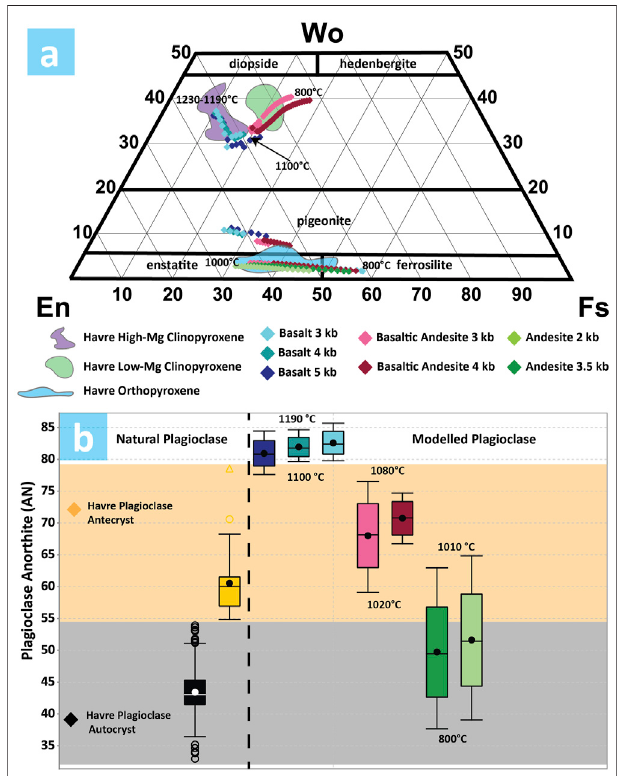
FIGURE 9 | Mineral chemistry comparison of measured Havre 2012 antecryst and rock fragment minerals versus rhyolite-MELTS calculated (A) clinopyroxene, orthopyroxene, and (B) plagioclase. (A) Rhyolite-MELTS model compositions are presented as closed diamonds with the color denoting the variable pressures of runs conducted for each step in crystal fractionation, where other initial conditions are presented in Table 3 . Fields of color represent the measured populations of Havre clinopyroxene, with the purple fi eld consisting of high-Mg clinopyroxene primarily observed in the Havre embedded rock fragments and Havre rhyolite, a green fi eld of low-Mg clinopyroxene identi fi ed as antecrystic in the Havre 2012 rhyolite, and a blue fi eld representing autocrystic orthopyroxene in the Havre 2012 rhyolite. (B) Box and whisker plots comparing the anorthite content of measured Havre (left of dashed black line) to the rhyolite-MELTS calculated plagioclase mineral chemistry (right of black dashed line). Havre 2012 plagioclase antecrystic cores (An 55 – 79 ) and autocrystic rims (An 34 – 55 ) are represented by the yellow and black fi elds, respectively. These natural ranges of plagioclase compositions are then compared to the calculated anorthite content from MELTS models. MELTS models are plotted in the same color as in panel (A) for the same model conditions. Note that high An content plagioclase is calculated primarily in basaltic to basaltic andesite models and autocrystic compositions are not produced until late in the andesite to dacite